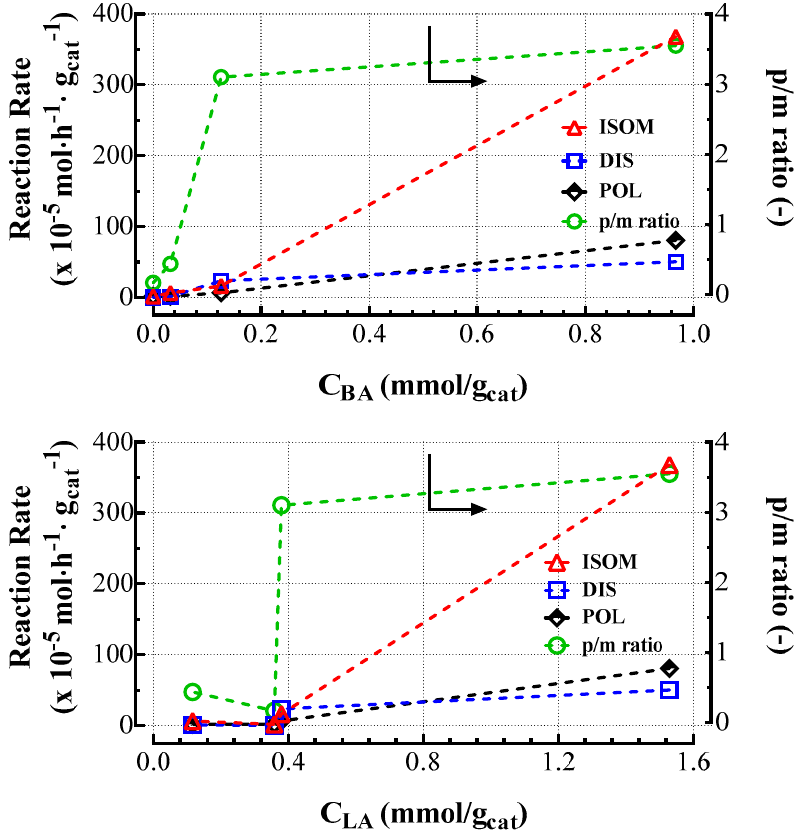
Figure 5. Correlation between catalytic data and the concentration of Brønsted and Lewis acid sites determined by FTIR measurements.